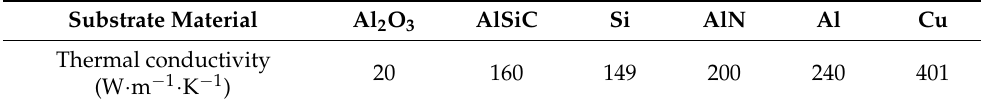
Table 1. Thermal conductivity of different substrate materials.